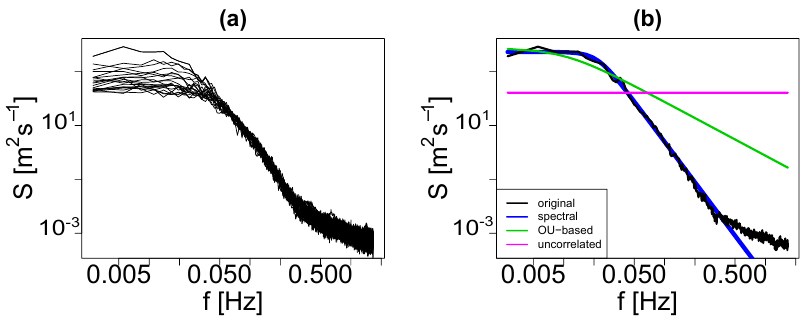
Figure 13. ( a ) PSDs of the weighting coefficients a j ( t ) for j = 1,2, . . . ,50; ( b ) PSD for a 2 ( t ) and the corresponding fit for the spectral model . Additionally, analytical PSDs for uncorrelated and OU-based model are shown corresponding to the estimated model parameters of these models.